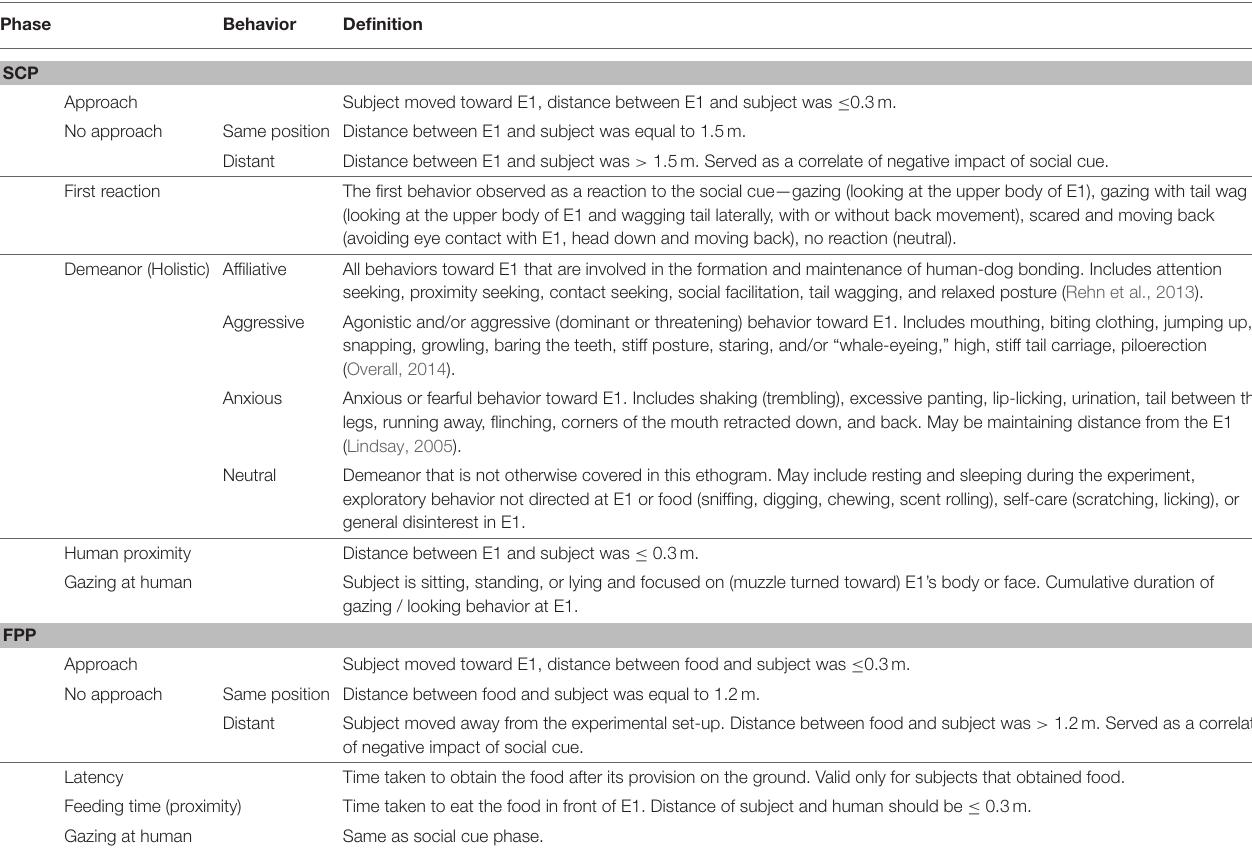
TABLE 1 | List of behaviors coded from the videos and their definitions.